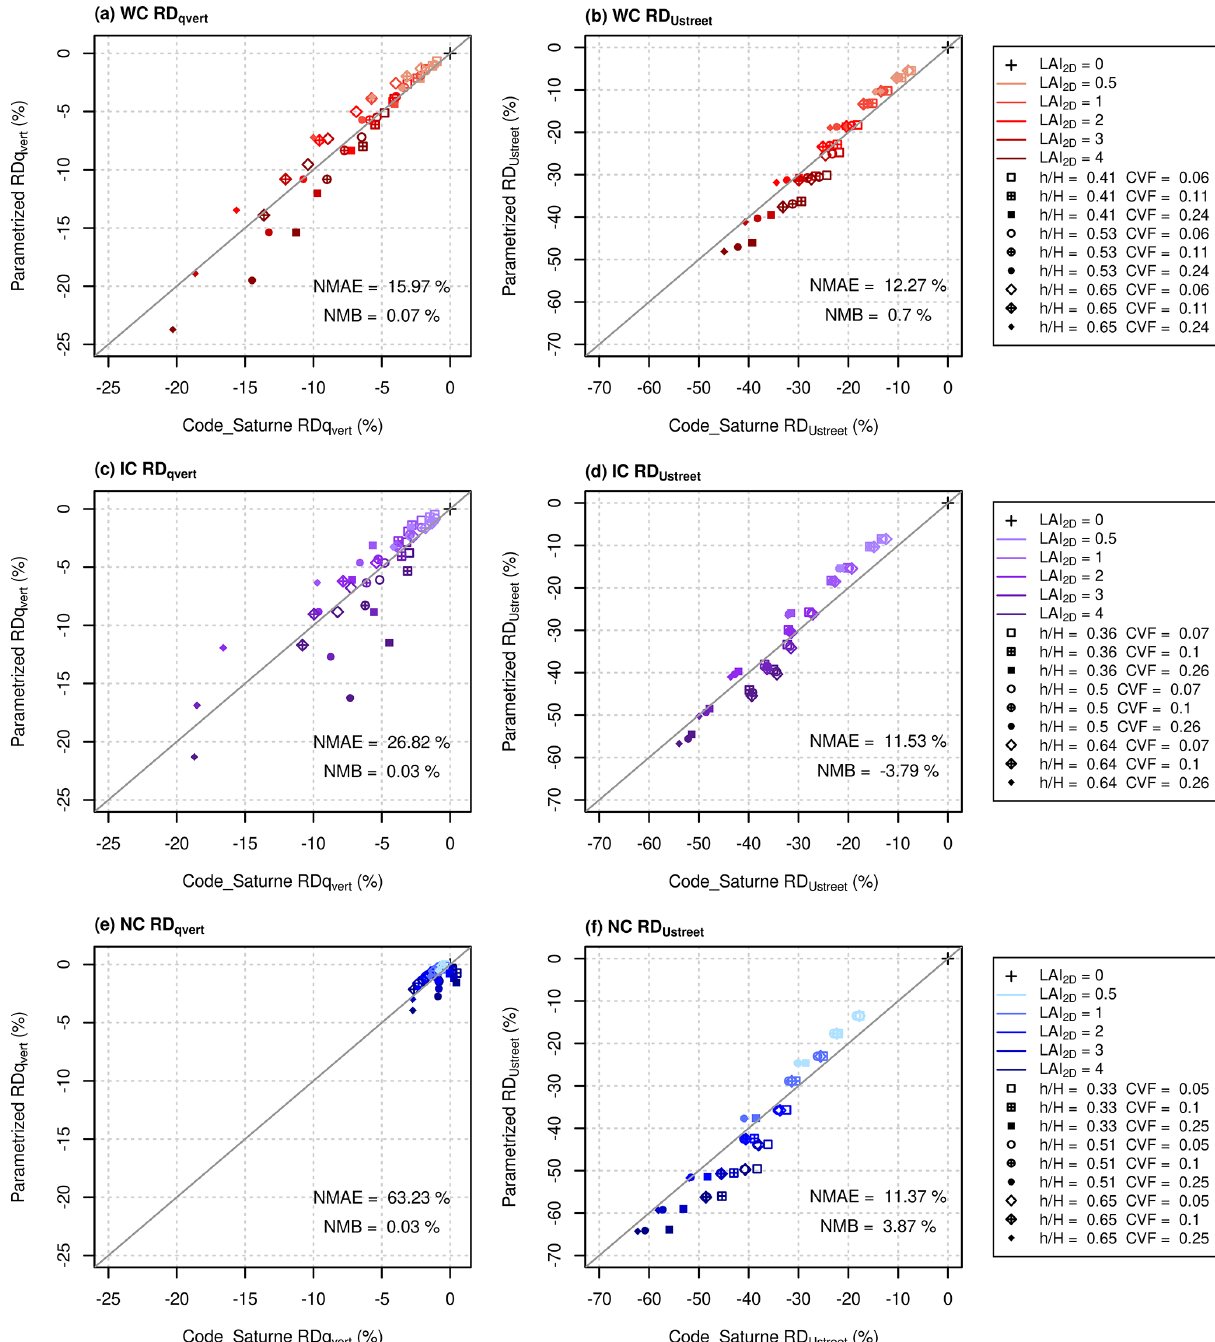
and (b, d, f) RD U computed from Code_Saturne simulations and parameterized in MUNICH vert street